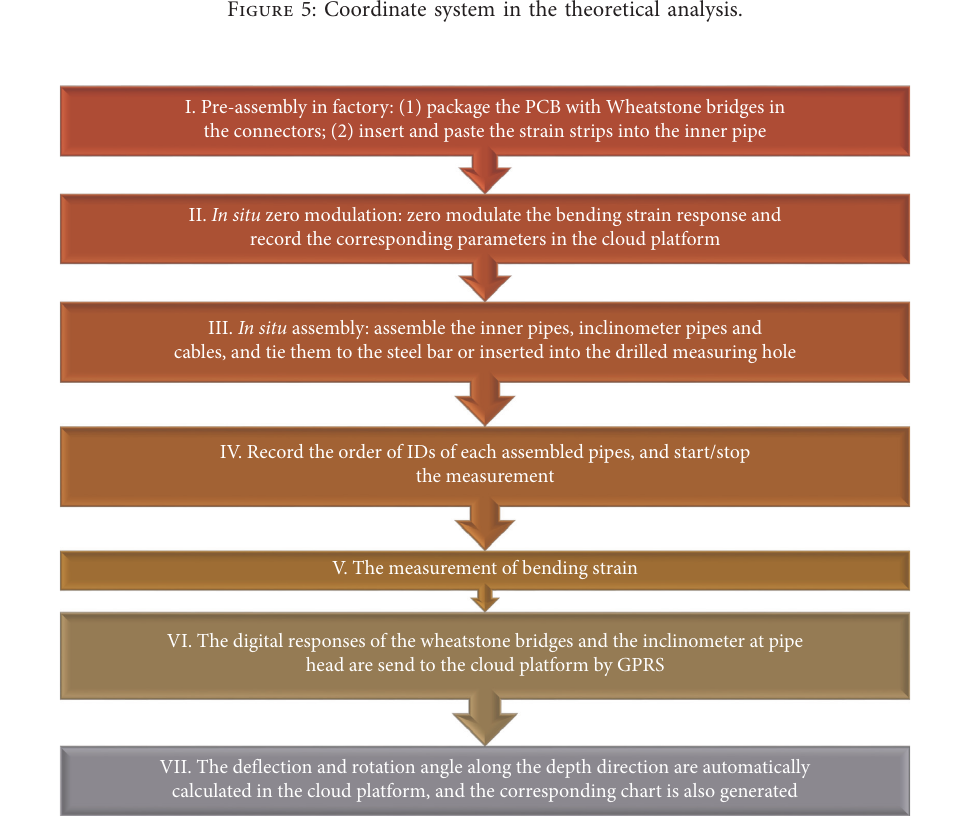
Figure 6: Flow chart of the